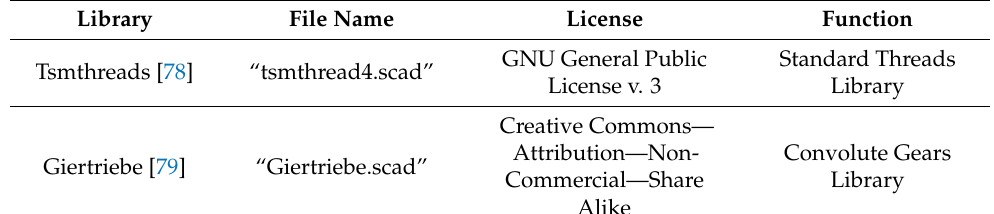
Table A2. Resulting functional variables from primary parameters.